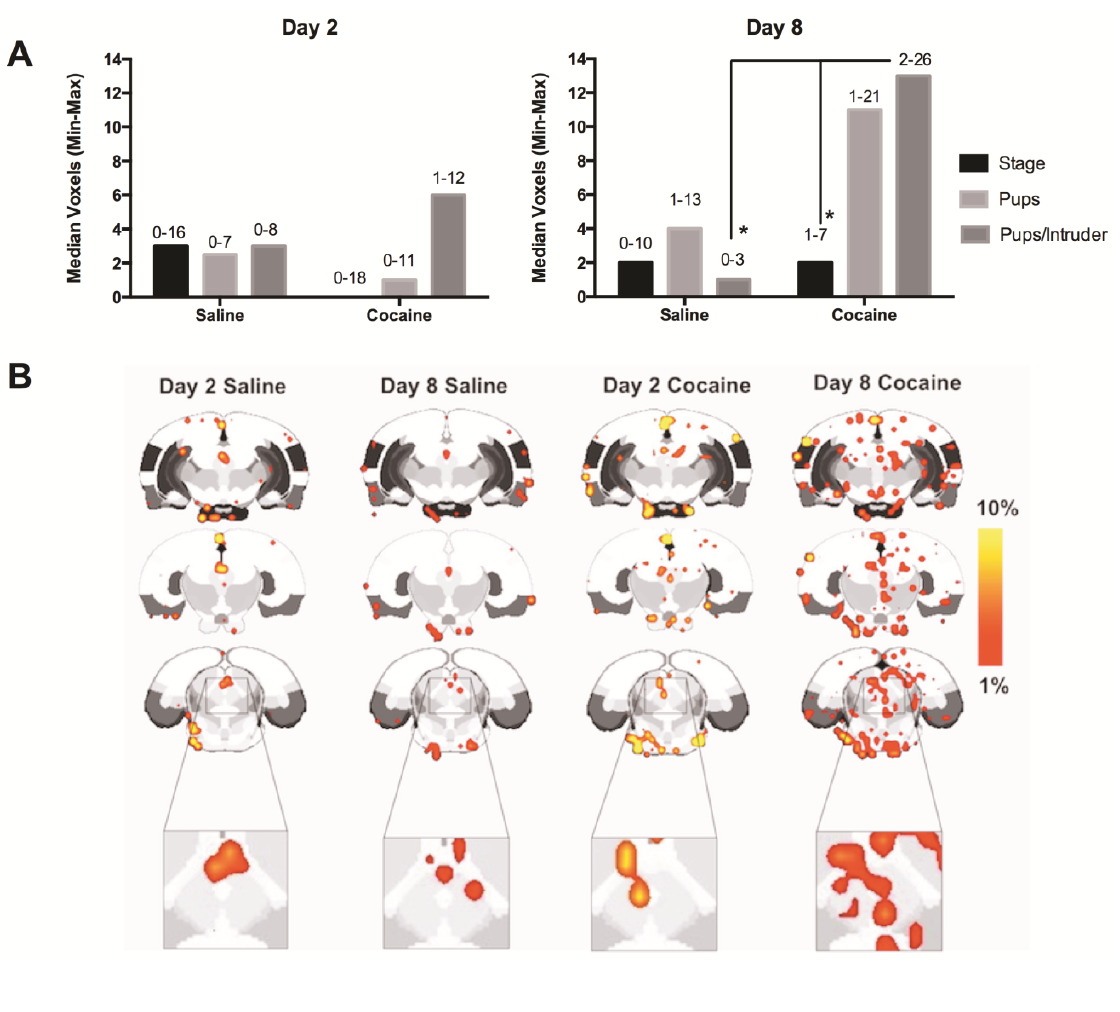
Figure 5. Median activated voxels in the PAG of saline and cocaine treated females presented with an empty stage, stage with pups, and pups with a male intruder rat on days 2 and 8 of pup sensitization ( A ), and composite activation maps showing areas of increased BOLD activation in rats presented with stage, stage with pups and pups and male intruder ( B ). Insets at the bottom highlight the area of the periaqueductal grey. Data are shown for control and cocaine treated rats on day 2 following initial exposure to pups and on day 8 after repeated sessions of exposure in their home cage. Color scale hue indicates percent change in signal